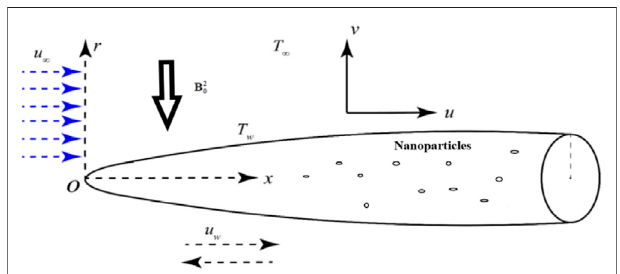
FIGURE 1 | Physical fl ow geometry.